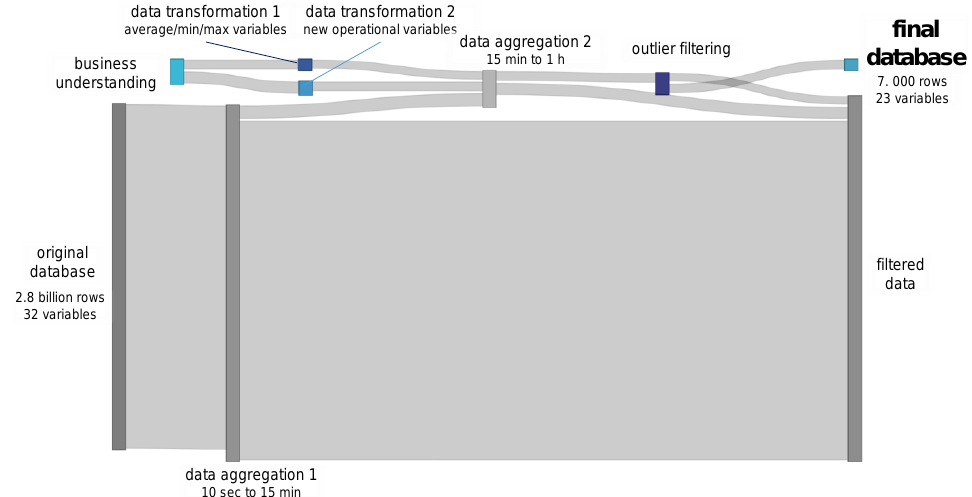
Figure 11. Sankey diagram of data quantity development through data aggregation and data transformation, unit is total number of data.